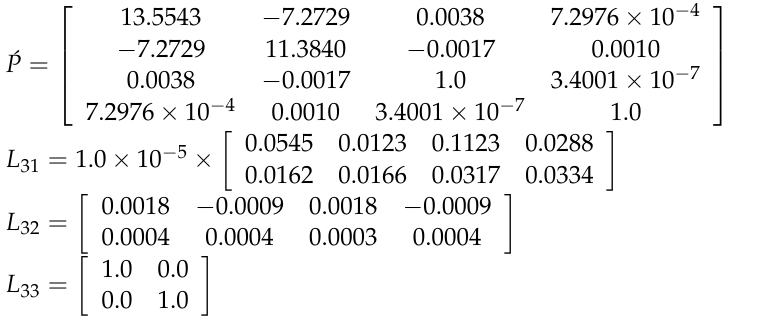
Table 2. Convergence details of Simulation 2.